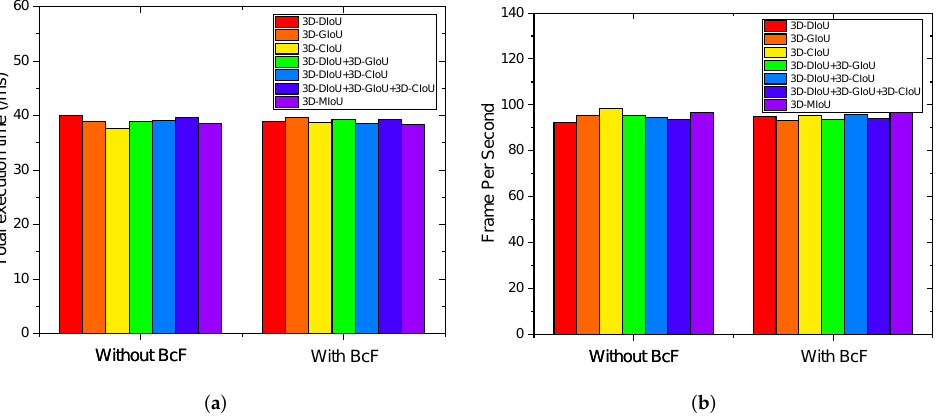
Figure 6. Total execution time and FPS of different metrics. ( a ) Total execution time. ( b ) Frames per